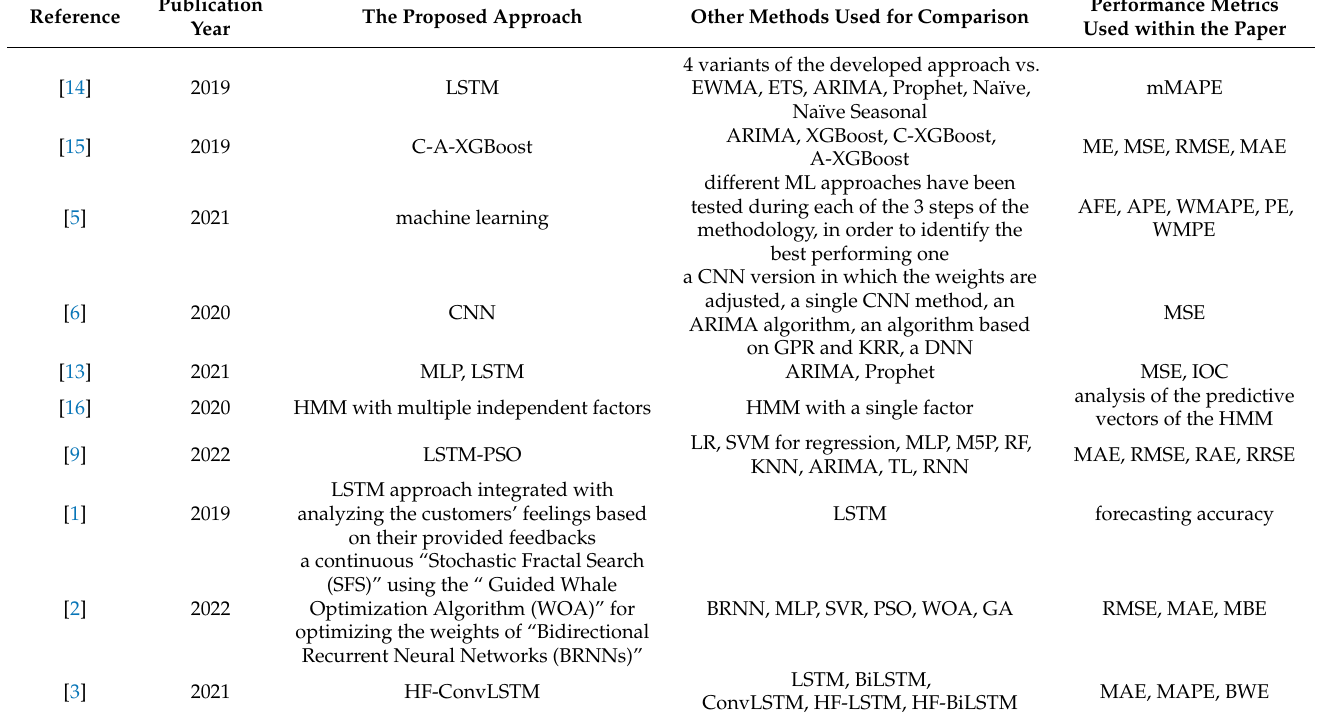
Table 1. A summary of the previously presented results related to the forecasting of sales revenues in e-commerce, reported within the scientific